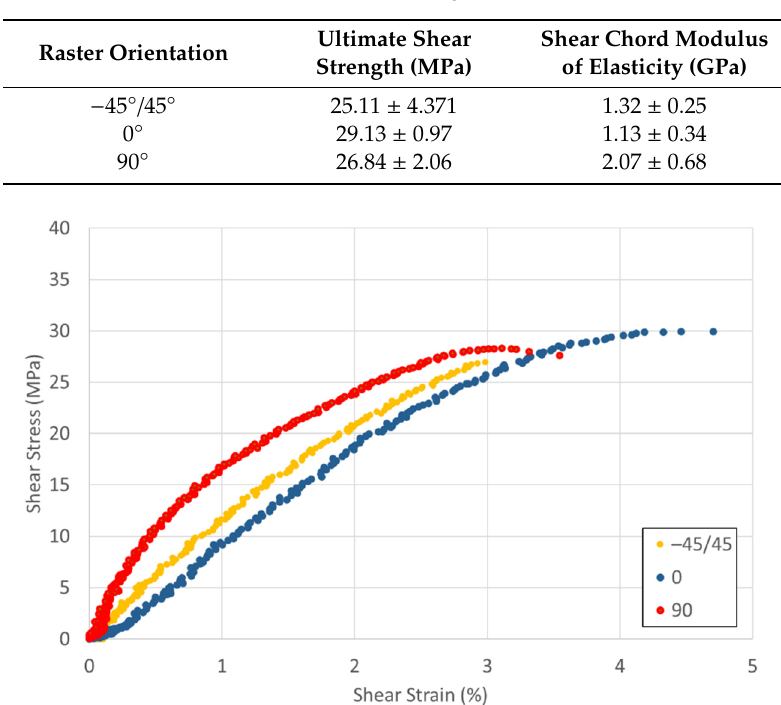
Table 6. Shear Testing Results.